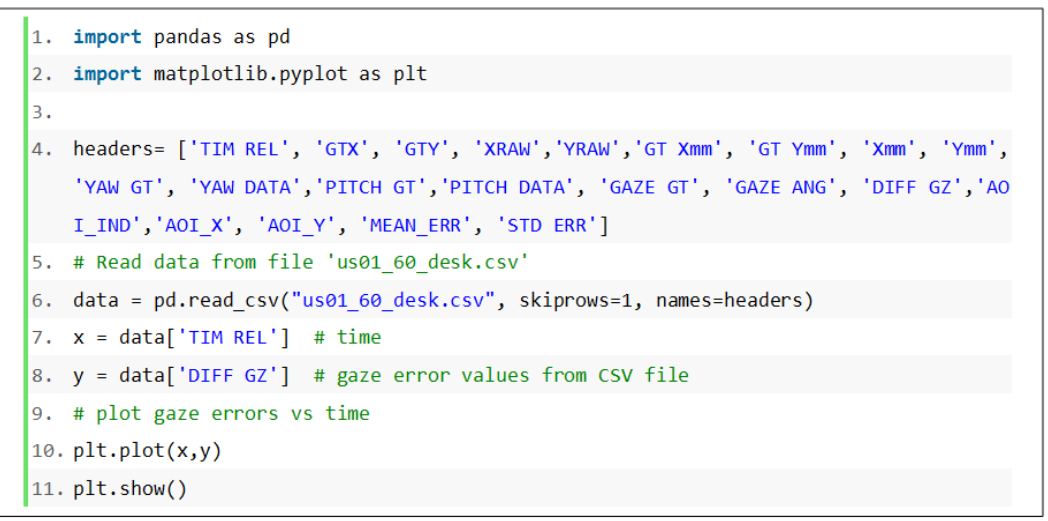
Figure 17. Python code snippet to read data from a gaze data file from NUIG_EyeGaze01 repository.